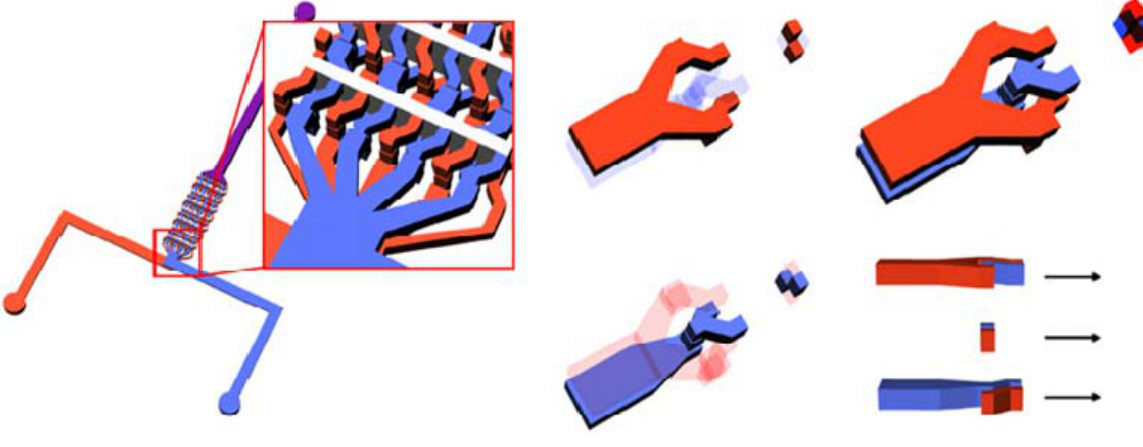
Figure 8. A schematic illustrating the structure of the chessboard mixer (from Cha et al.